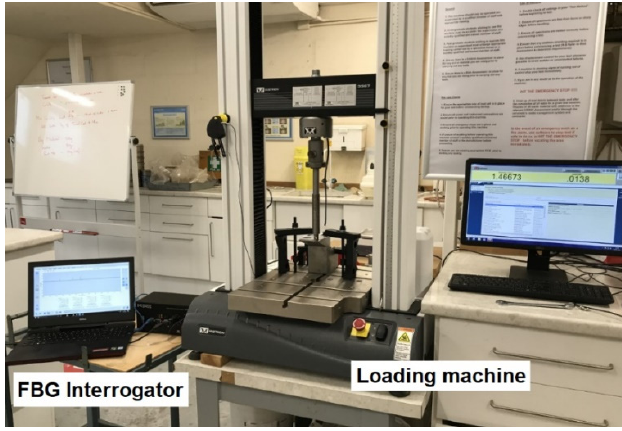
Figure 6. The set-up used for the experimental strain measurement tests.